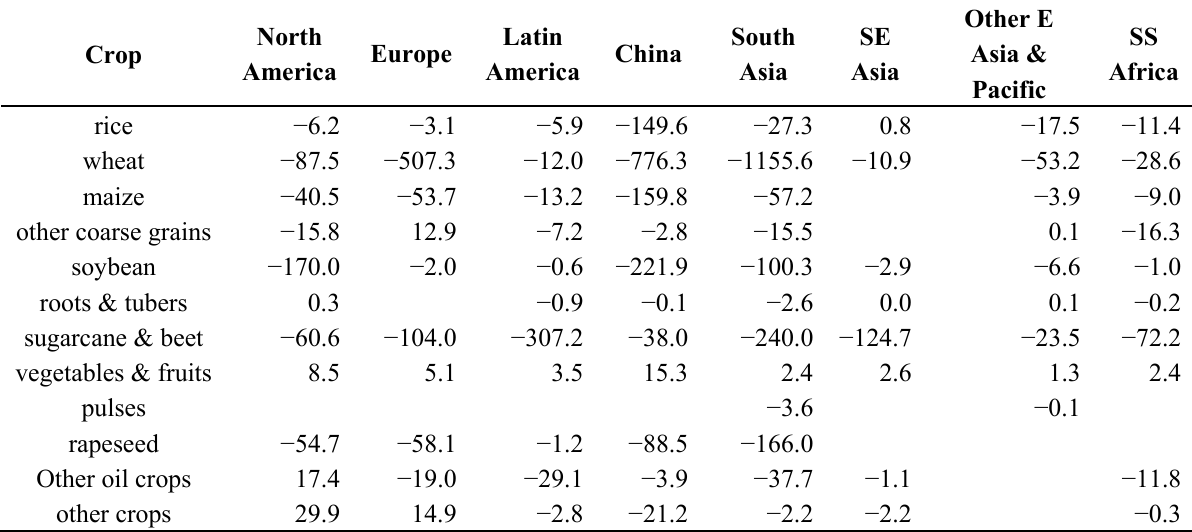
Table 4. Changes in crop area from baseline in 2020 (thousands of hectares). North Europe Crop America